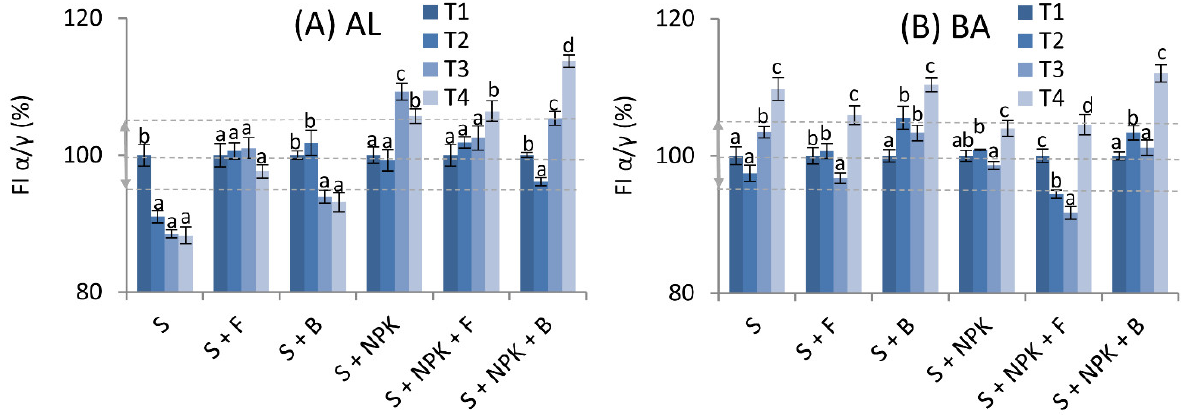
Figure 4. Changes in fluorescence intensity (FI) α / γ ratios in the form of relative values with ± 5% thresholds marked in gray lines; ( A )—humic acids (HAs) from Abruptic Luvisol (AL) soil, ( B )—humic acids (HAs) from Brunic Arenosol (BA) soil. The values measured at T2, T3, and T4 were compared to the control (100%), marked as T1. S—soil without additives, S + F—soil with fungal strains, S + B—soil with bacterial strains, S + NPK—soil with NPK, S + NPK + F—soil with fungal strains and NPK, S + NPK + B—soil with bacterial strains and NPK. The figure shows mean values ± standard deviation. The same small letters mean no significant differences between the values at the level of significance α = 0.05 (one-way ANOVA variance analysis, Tukey’s HSD test).